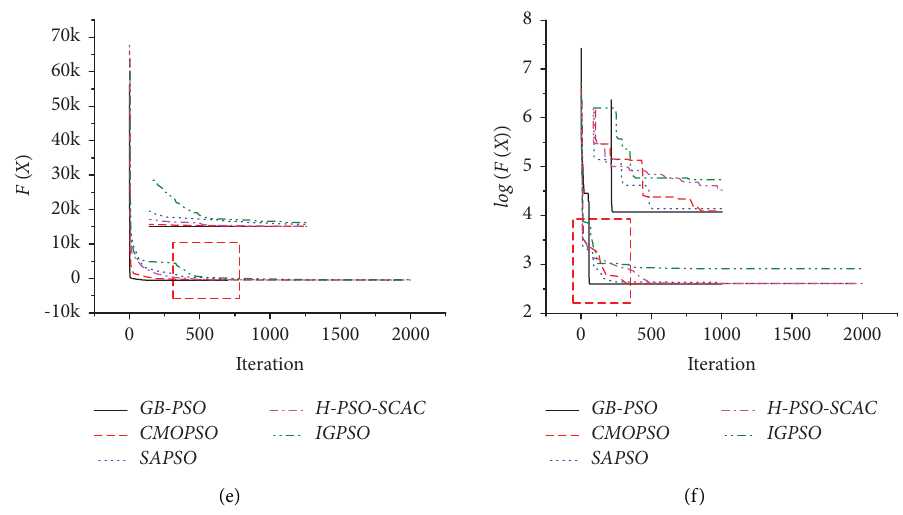
Figure 8: Te variation curve of the best mean ftness value. (a) f